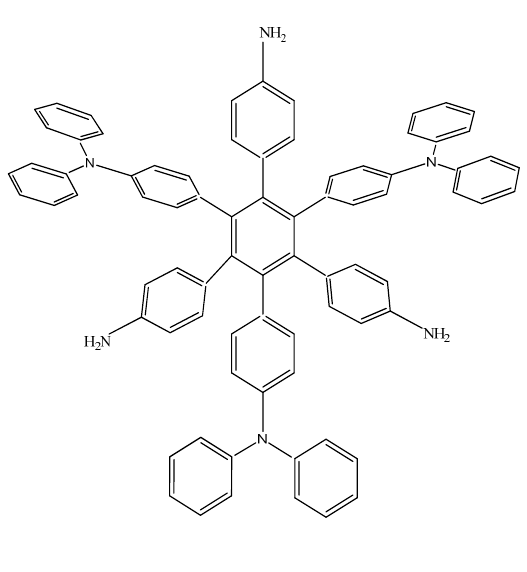
Figure 12. Structure of HAB6